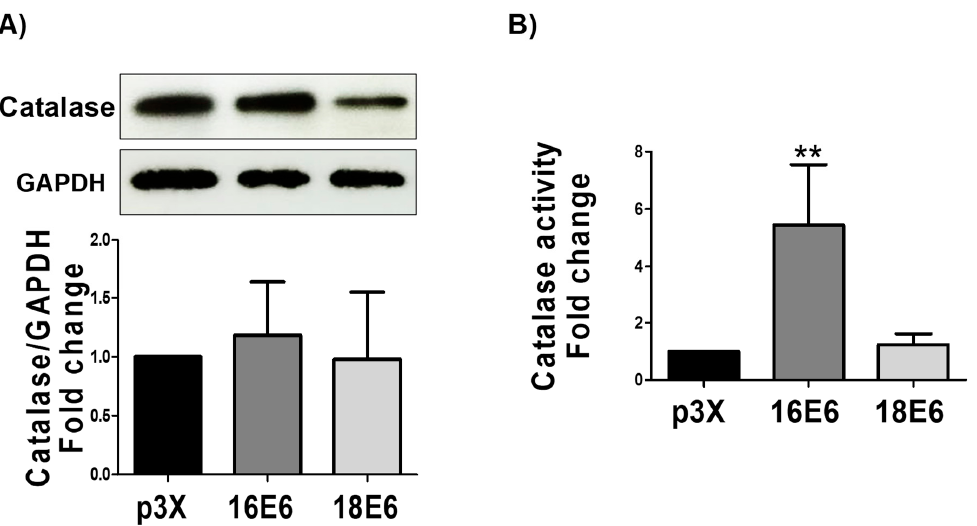
Figure 10. E ff ect of E6 oncoproteins from HPV16 and HPV18 on catalase levels and activity. ( A ) Representative immunoblot and quantitative densitometric analysis of catalase; ( B ) catalase activity in FaDu transfected cells. GAPDH was used as a loading control. Data are expressed as the mean ± SD. Tukey’s test ** p < 0.005 vs. p3X control, n = 3.